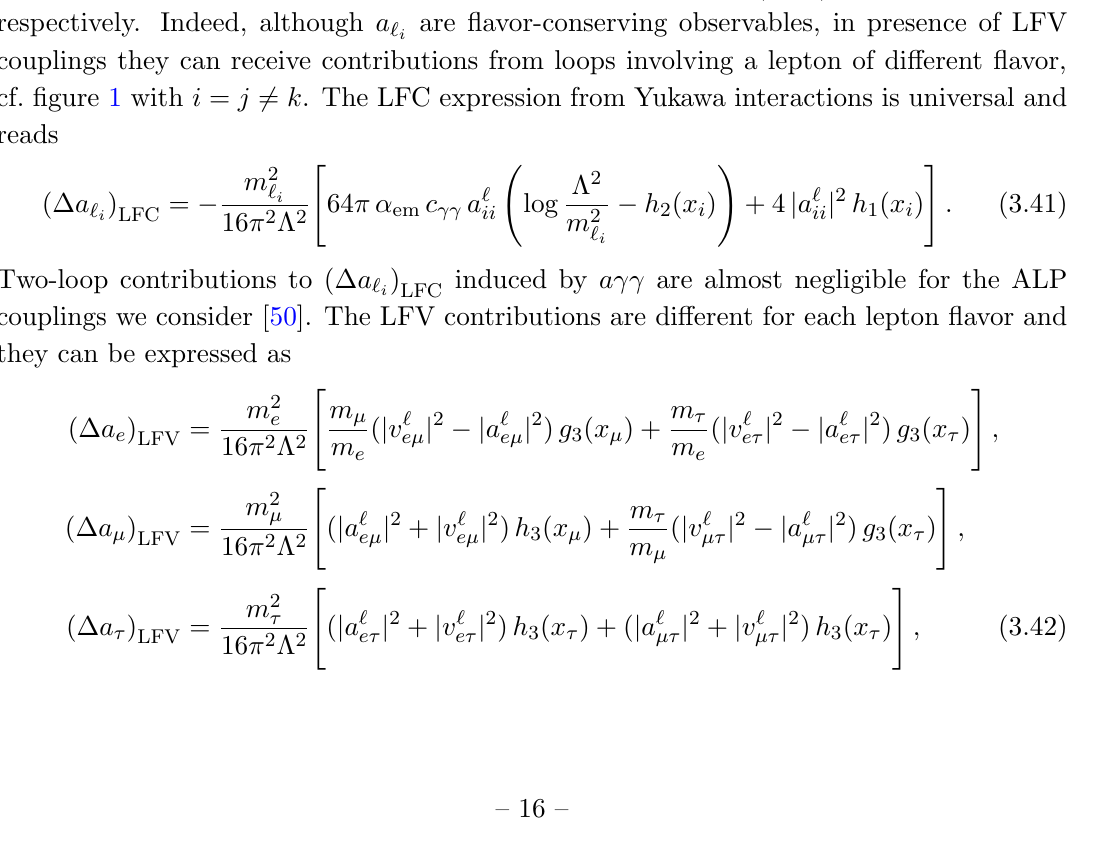
Figure 6 . ( (cid:22) +Au e +Au) = ( (cid:22) e(cid:13) ) is plotted as a function of m a for a ‘ B ! B ! various values of the coupling c (cid:13)(cid:13) . We assume that a ‘